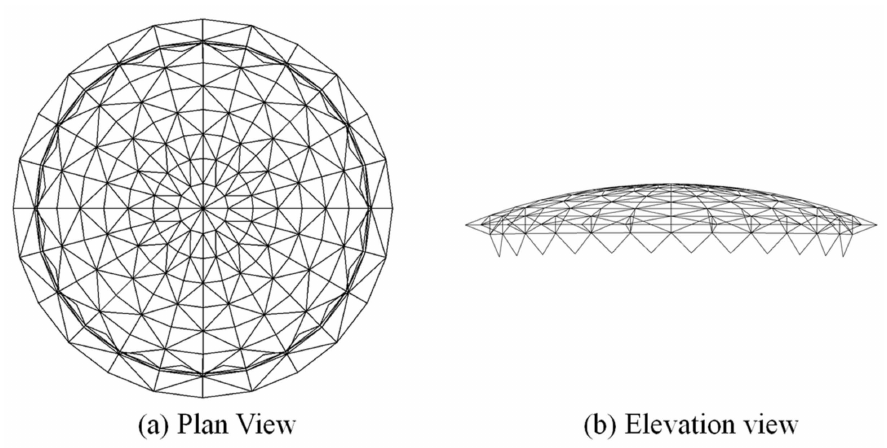
Figure 6. Overall structure